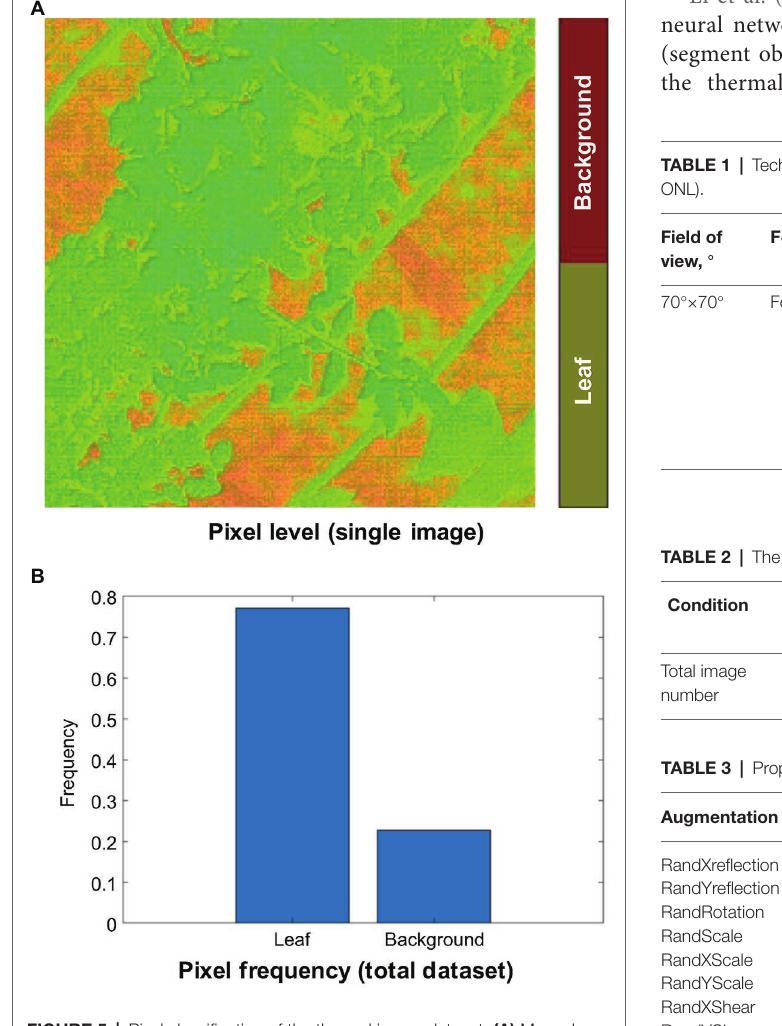
FIGURE 5 | Pixel classification of the thermal image dataset. (A) Manual annotation. (B) Frequency level of the annotated leaf and background pixels within total thermal image dataset.